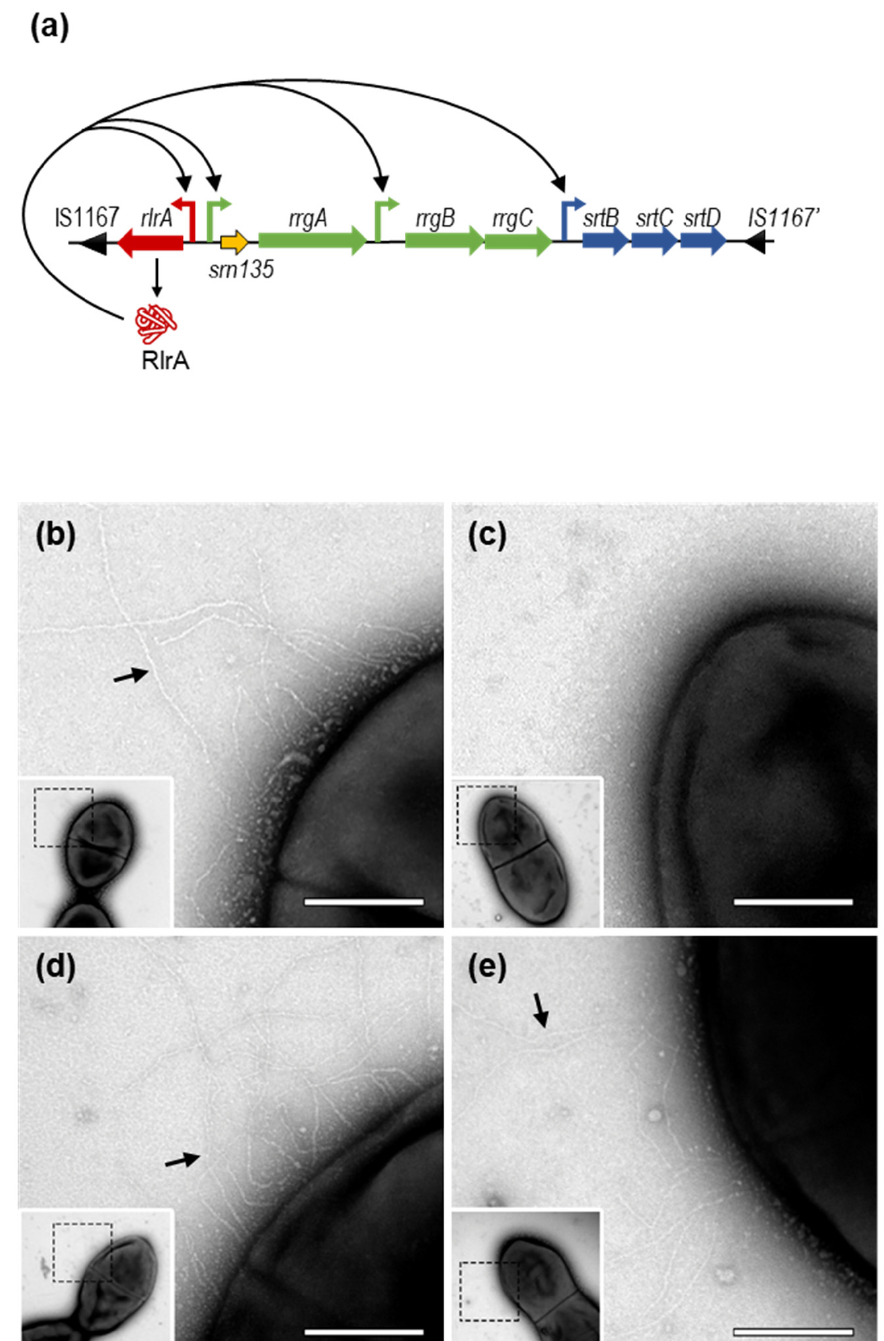
Figure 1. Type-I pilus of Streptococcus pneumoniae . ( a ) Schematic representation of Streptococcus pneumoniae TIGR4 pilus-island 1 (PI-1). Genes are represented by arrows facing the direction of transcription. The transcriptional regulator rlrA is red; the three structural proteins are green, and sortases are blue. The coding sequence of srn135 is orange. The RlrA protein is represented as a red icon. Curved arrows represent the three transcriptional promoters found in the PI-1. The positive regulation exerted by RlrA as previously described is depicted by pointed arrows. Transmission electron microscopy of negative-stained strains: ( b ) TIGR4 wild type pilus-positive control, ( c ) TIGR4 Δ rlrA pilus-negative control, ( d ) TIGR4 Δ rrgA , and ( e ) the TIGR4 Δ srn135 , showing fine pili protruding from the bacterial surface (black arrows). Bacteria were allowed to adsorb to Formvar carbon-coated grids and negatively stained with 2% ( w / v ) uranyl acetate. Scale bar: 250 nm.